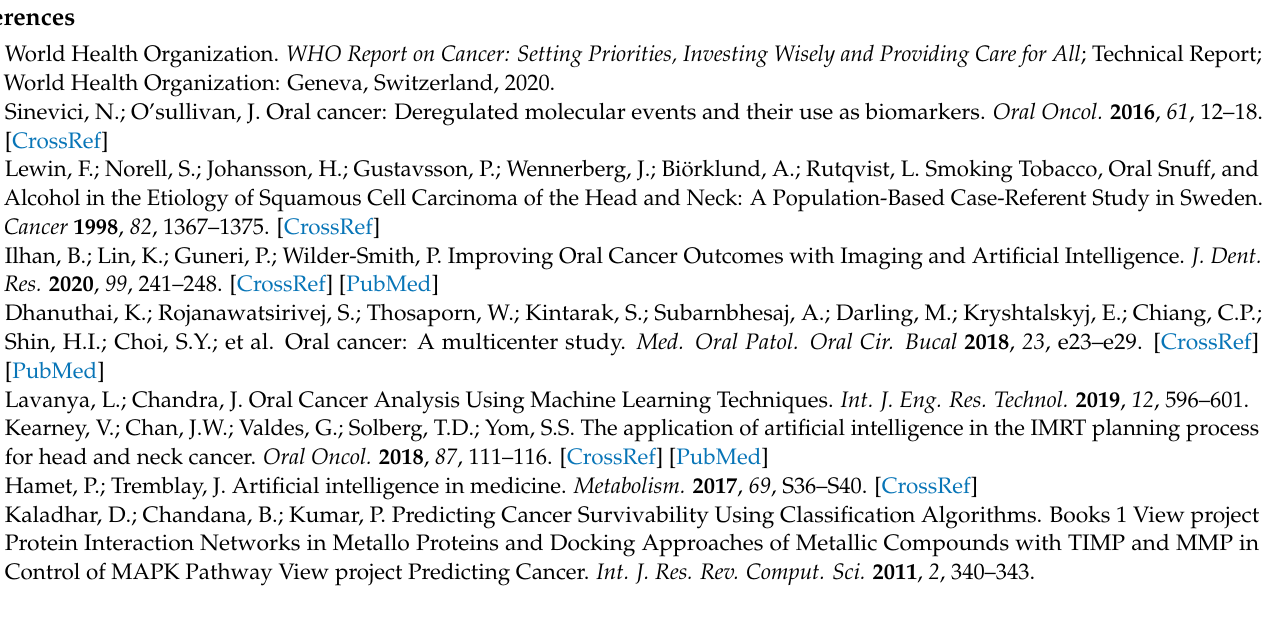
bias; Table S2: Quality assessment (QUADAS 2) summary of applicability